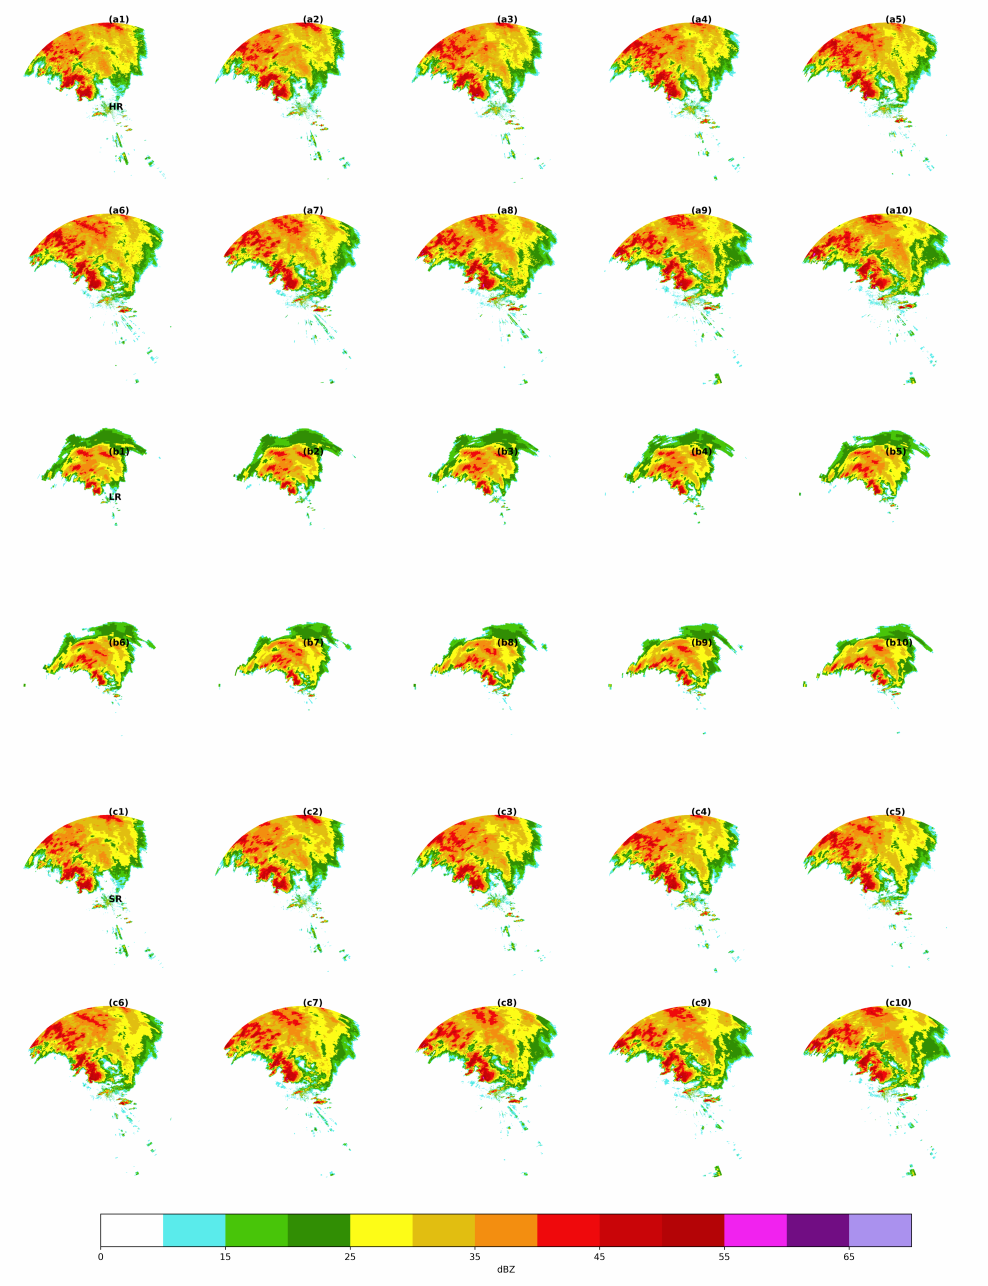
Figure A3. Tornado data on the scaling factor ×